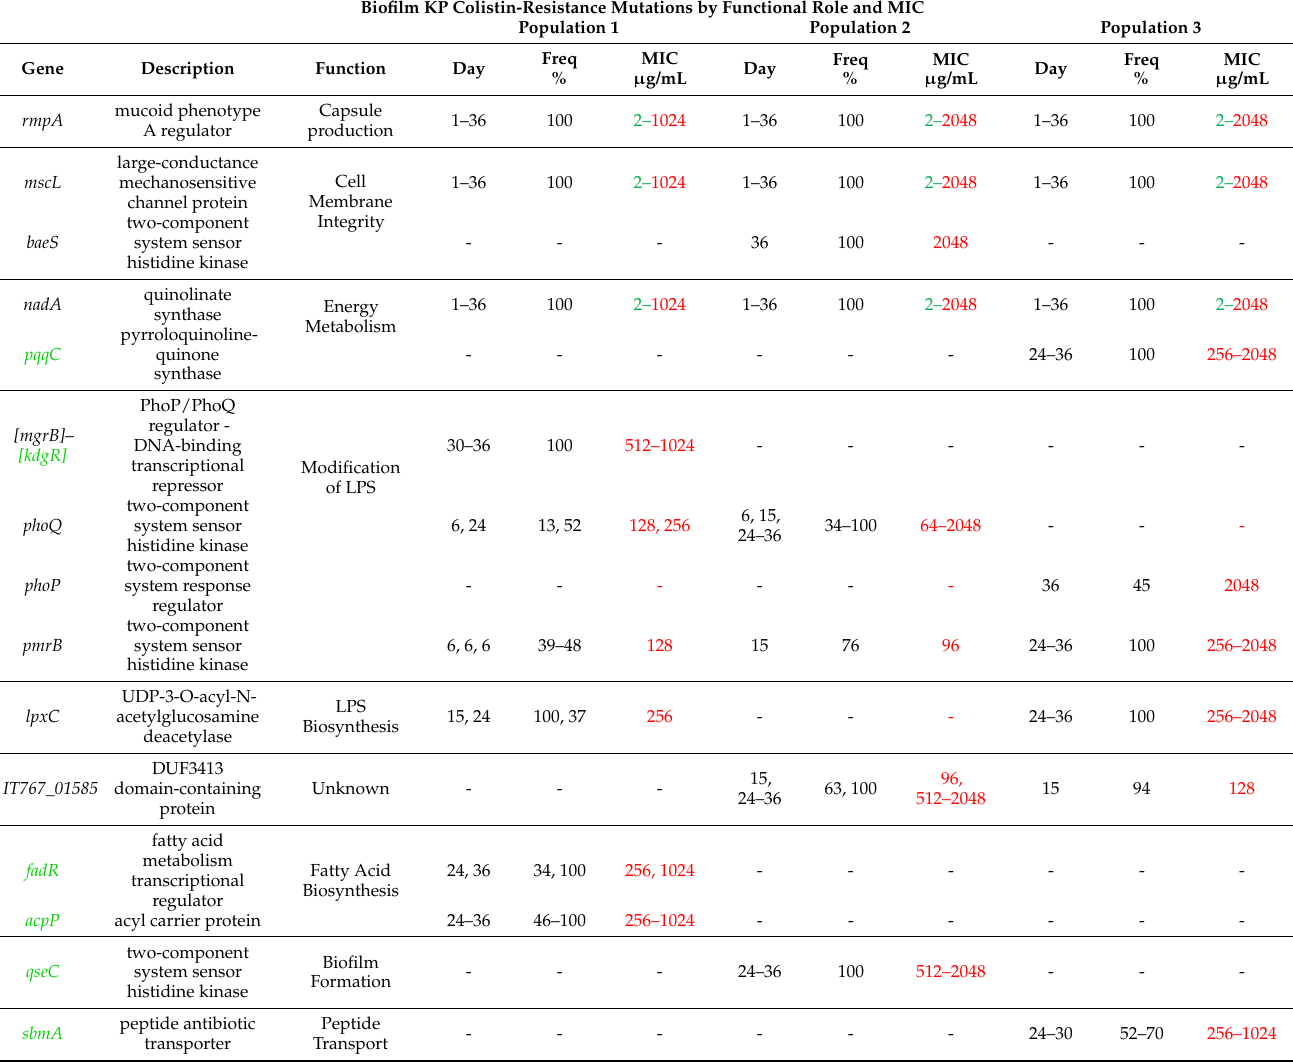
Table 4. Functional roles of COL-R mutations in relation to timing, population frequency (percentage), and colistin MIC ( µ g/mL) for biofilm-evolved KP. Resistant MICs are shown in red, sensitive MICs are shown in green, and mutations independent to biofilm lifestyle are shown in